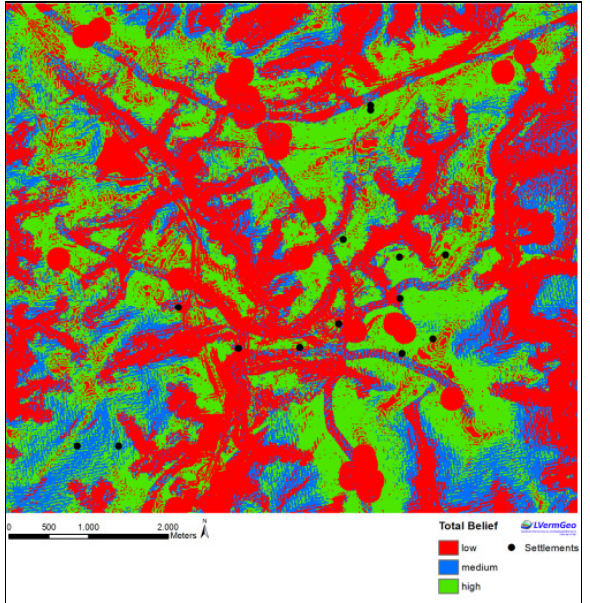
Figure 4. Total Belief of the hypothesis „Presence of